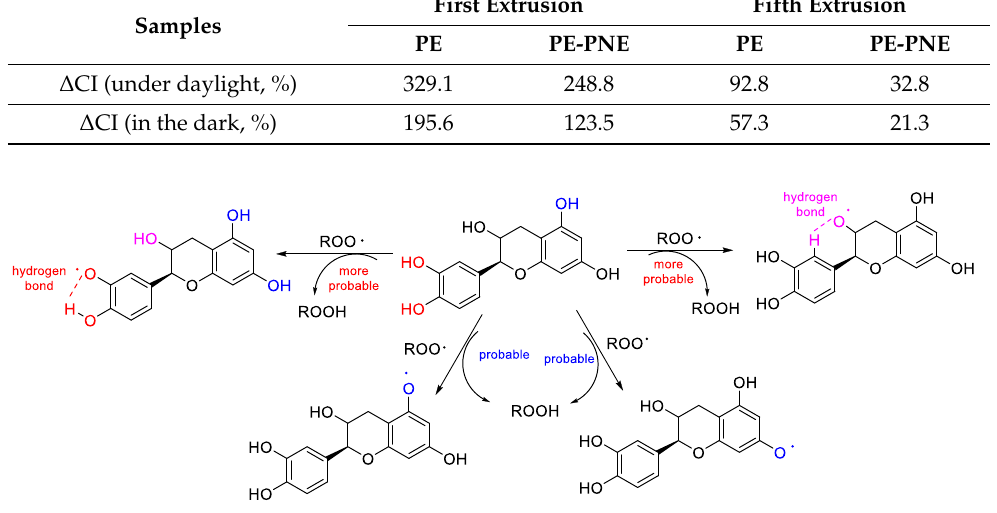
Scheme 2. Possible role of Catechin during